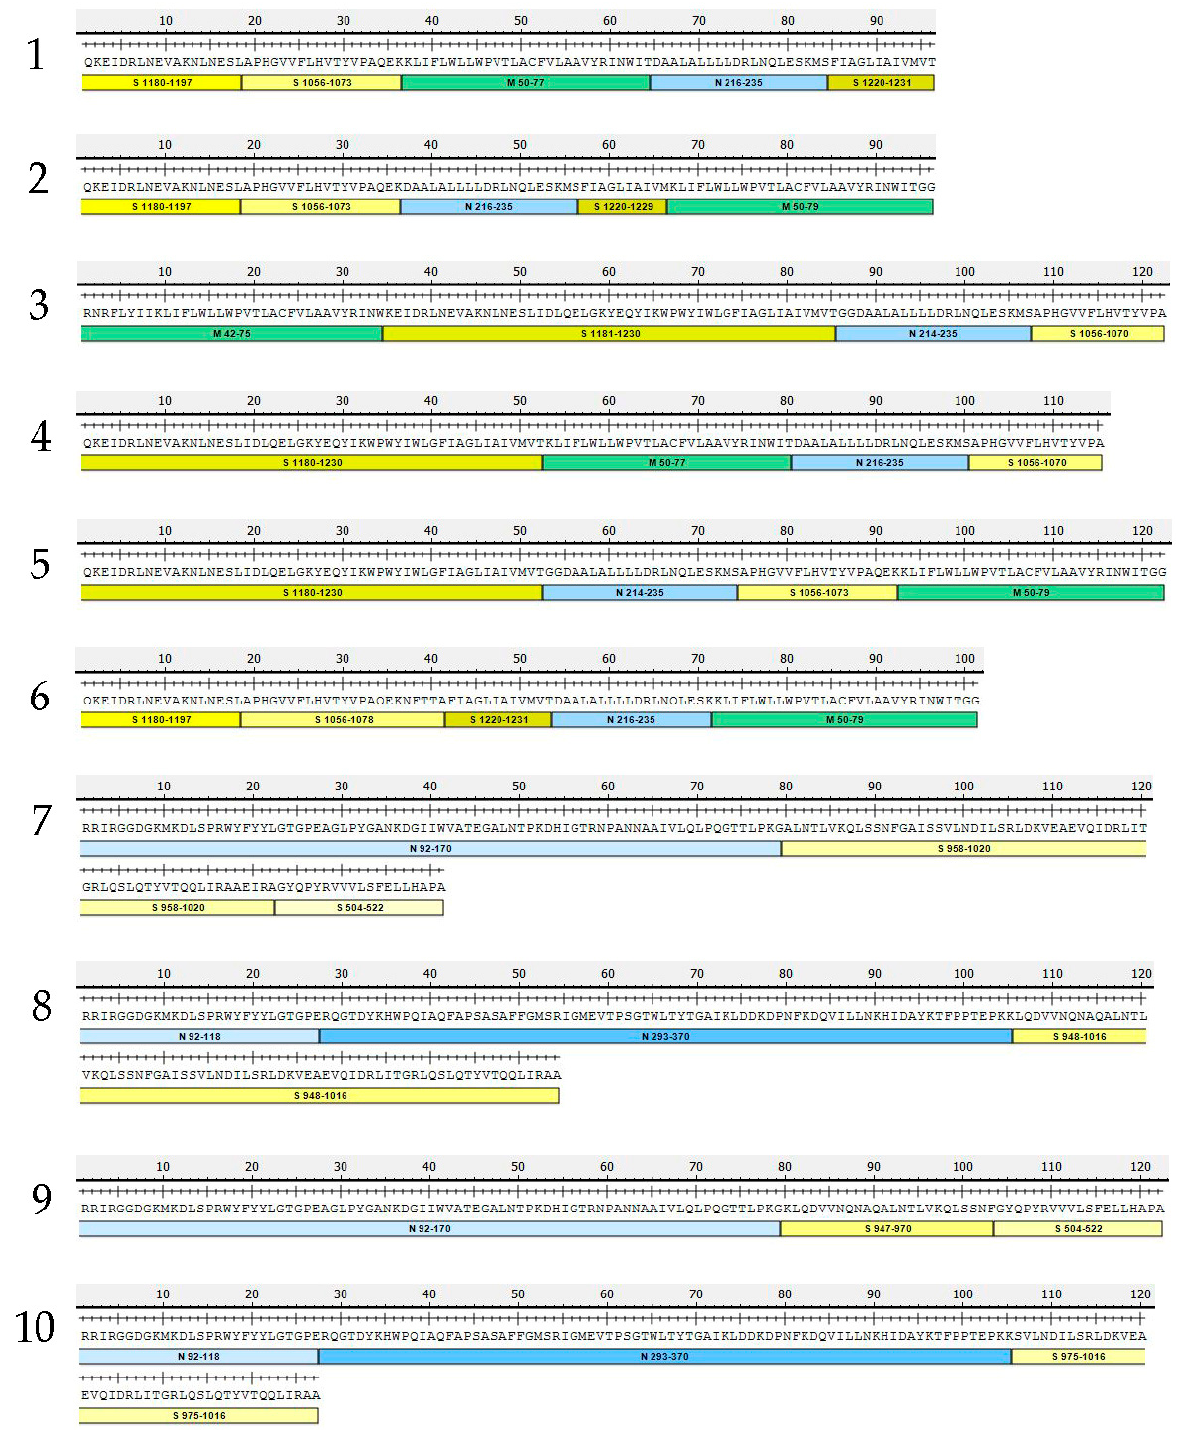
Figure 1. A schematic representation of selected cassettes comprising a panel of promising SARS- CoV-2 T-cell epitopes with confirmed processing and immunogenicity, as well as peptides that were reported to form complexes with different human MHC molecules. The cassettes were chemically synthesized and incorporated into the genome of LAIV virus.